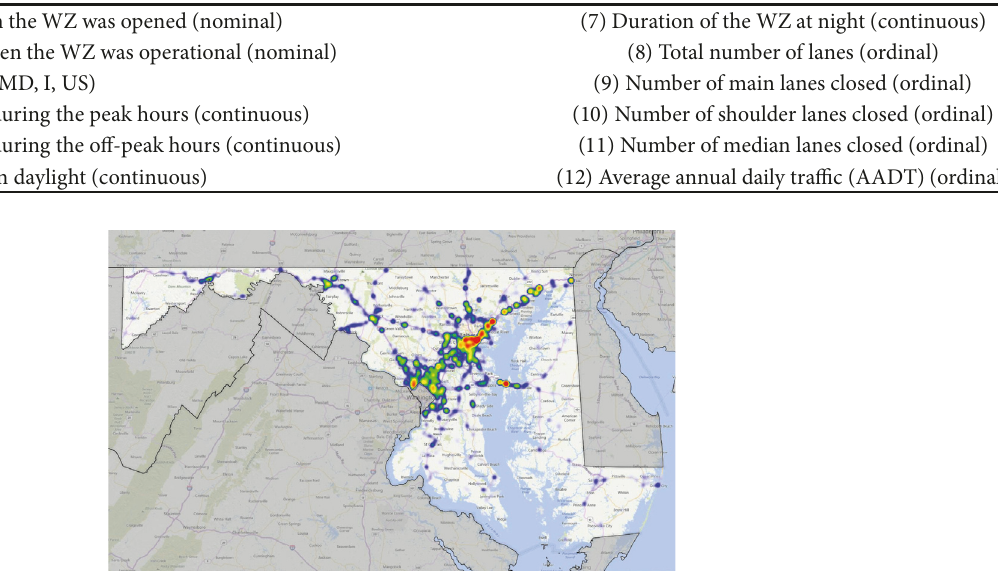
Table 1: Input variables considered in the analysis of WZ collisions.